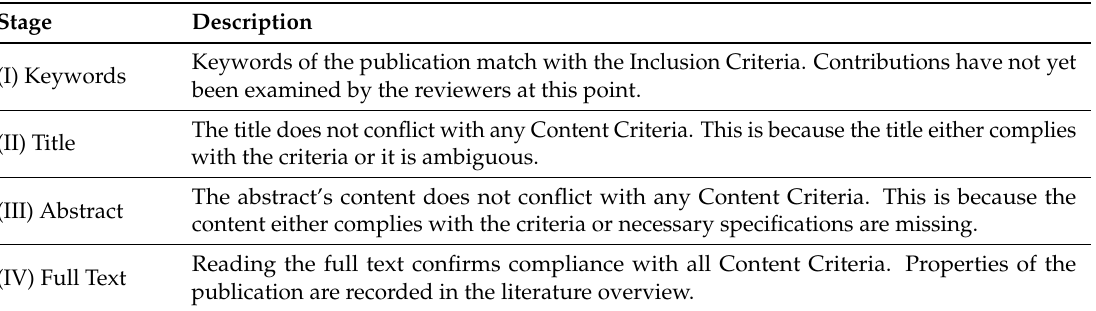
Table 4. Stages I–IV of selection